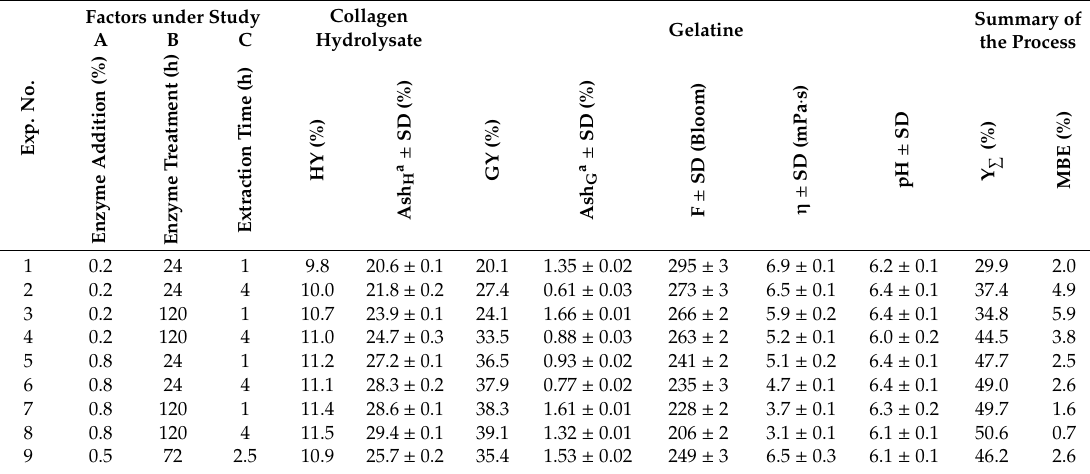
Table 1. The experimental design and the results of processing of chicken feet into gelatines (study of the influence of process